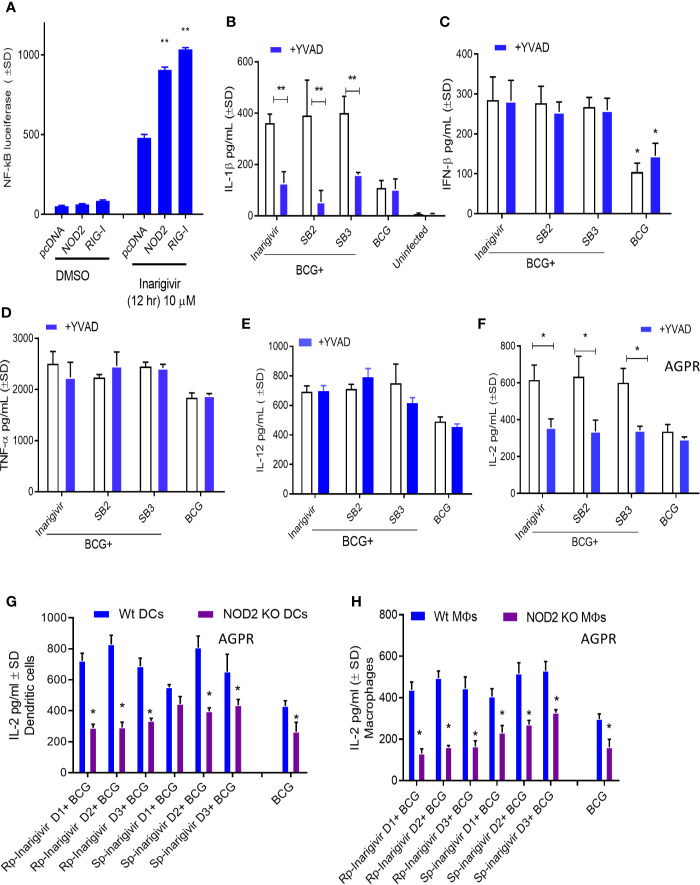
Inarigivir activates NOD2/RIG-I receptors enhancing Capsase-1 dependent IL-1β secretion and NOD2 dependent antigen presentation. HEK cells were used for assay of receptor activation (A) and wild type C57Bl/6 (B–F) or NOD2−/−
(G–H) mouse derived APCs were left either untreated or treated with Inarigivir, Rp-Inarigivir and Sp-Inarigivir and SB-2 or SB-3 (10 µM), followed by inhibitors as indicated, and where indicated, a 4-h infection with BCG (MOI = 1). Supernatants were tested for cytokines at 18 h or APCs overlaid with BB7 CD4 T cells for antigen presentation assay to measure IL-2. (A) Induction of NF-kB activity by Inarigivir (mix of Rp-Inarigivir and Sp-Inarigivir) through NOD2 and RIG-I activation. HEK-293 cells were transfected with pcDNA, NOD2, RIG-I, and NF-kB-luciferase. The cells were then incubated with Inarigivir (10 µM). Following 12 h incubation, Luciferase activity was measured and presented as mean ± S.D. from three independent experiments. (B) Rp-Inarigivir and Sp-Inarigivir combinations with BCG increase IL-1β secretion which is decreased after Caspase-1 blockade using Z-YVAD-fmk (50 µM). (C–E) IFN-β, TNF-α, and IL-12 cytokines are not affected by the Caspase-I blockade, although Inarigivir, SB2 and SB3 enhance IFN-β levels. (F) Caspase-1 blockade decreases antigen presentation. (G, H) Rp-Inarigivir and Sp-Inarigivir enhance antigen presentation by BCG infected wt-APCs, which is decreased in NOD2−/− APCs. (* < 0.01 ** < 0.006 p values using 1-way ANOVA with Tukey’s posttest). Data are representative of 2 independent experiments carried out in duplicates and values are expressed as mean ± SD.